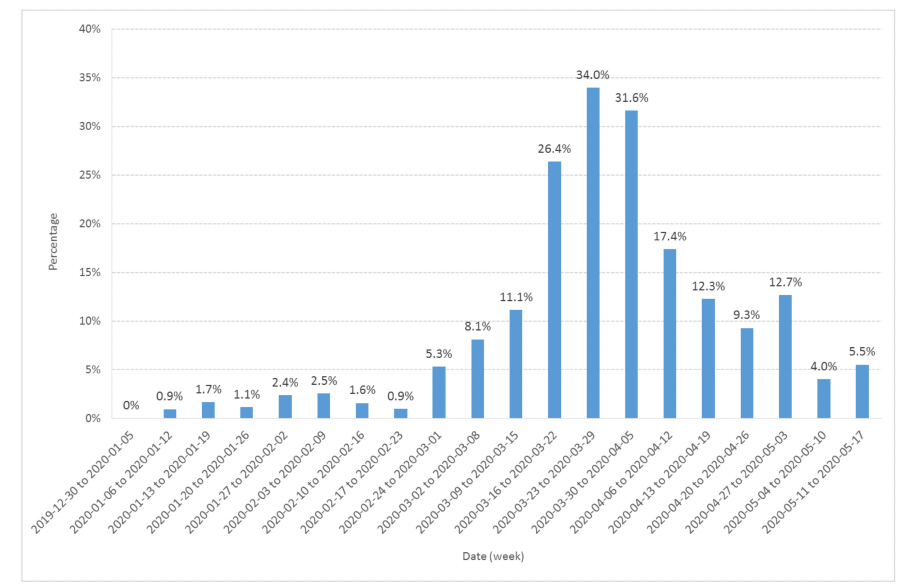
Figure 2. Fraction (expressed in %) of the Diaconat-Fonderie emergency care service weekly visitors retrospectively diagnosed as probable or confirmed COVID-19 cases from 30 December 2019 to